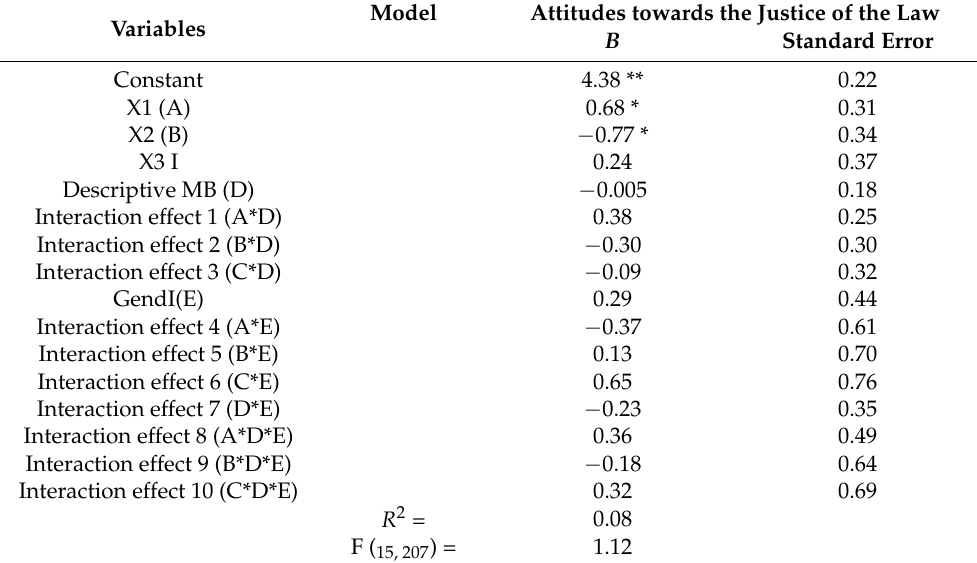
Table 3. Testing the Moderating Effect of Descriptive MB and Gender on the Relationship Between the AAM Type and Attitudes Towards the Fairness of the Law.